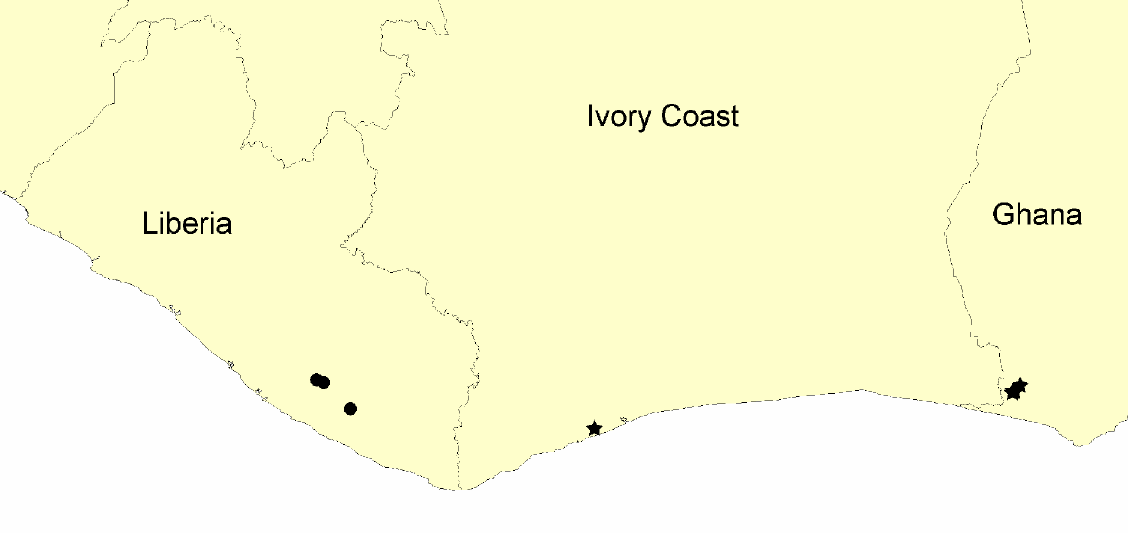
Fig. 4. Distribution map. Gaertnera luteocarpa sp. nov. subsp. luteocarpa (stars) and G. luteocarpa subsp. sinoensis subsp. nov. (dots).